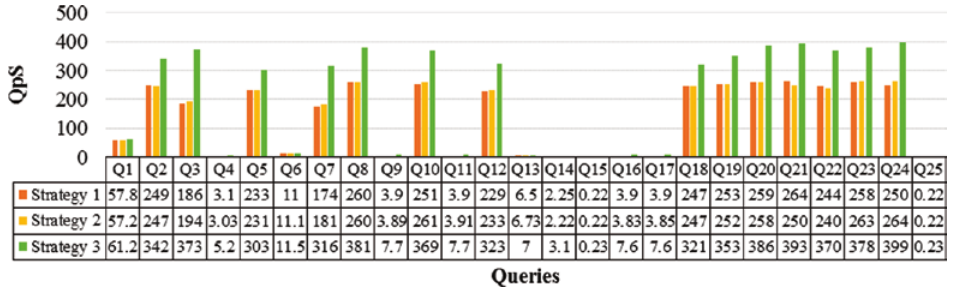
Figure 9: QpS Analysis of Three Strategies on Three Ontologies and A-BOX of Size 5L.